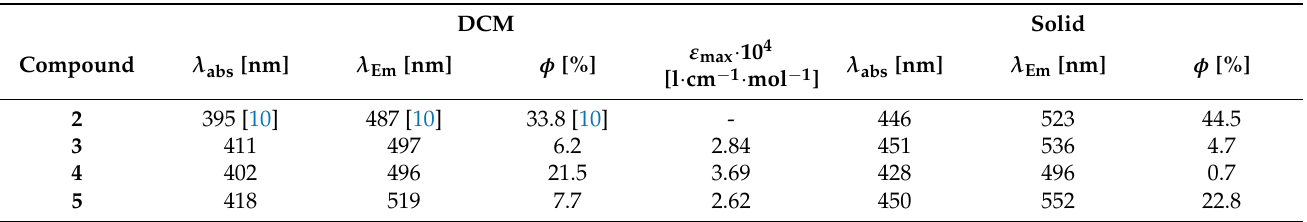
Table 1. Photophysical properties of the investigated compounds in solution (DCM, 10 − 5 M) and solid state. DCM